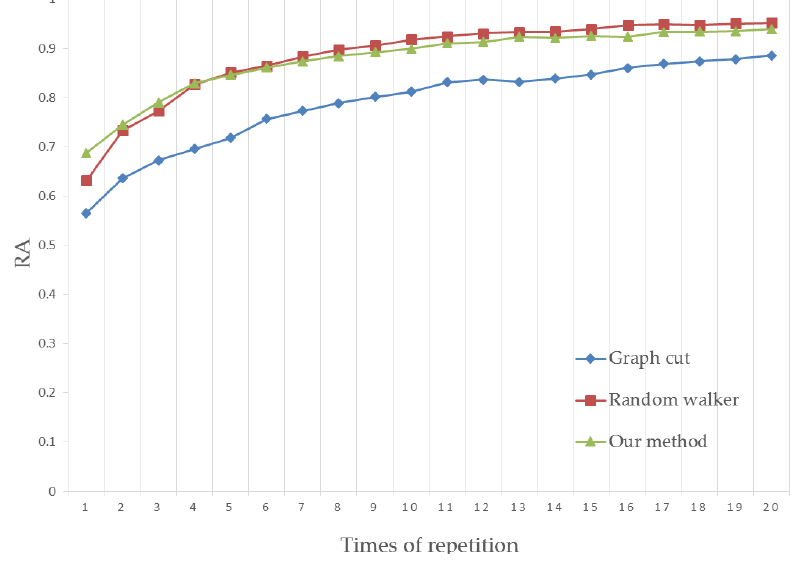
Figure 13. Region accuracy comparison.